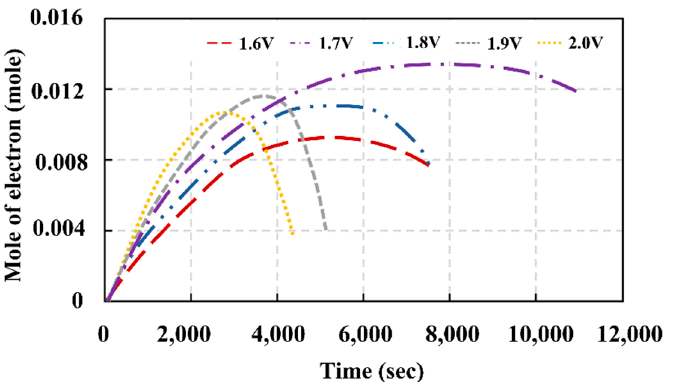
Figure 6. The moles of electrons occurring during redox as a function of time during the electrolyte preparation period .